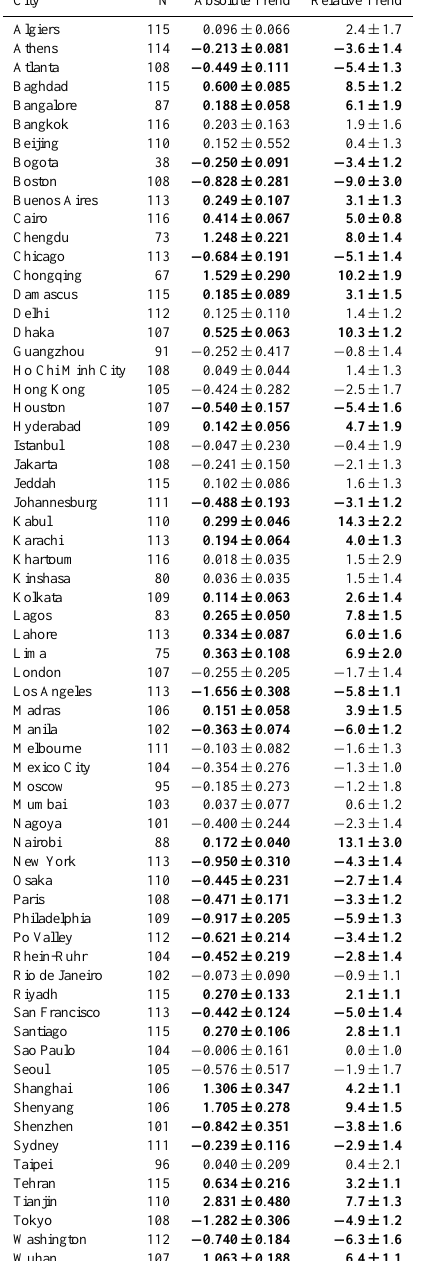
Table 3. Trend analysis results for all studied large urban agglomer- ations. The absolute trends and their uncertainty are given in units of × 10 15 moleculescm − 2 yr − 1 and the relative trends and their uncer- tainty are given in % yr − 1 . The trends shown here were computed using time series extracted from a single grid cell located over the center of each agglomeration. The relative trends were computed with respect to the long term mean of the time series over a given grid cell. Trends that were found to be statistically significant at the p < 0 . 05 level are marked in bold. N indicates the total number of months in the time series with valid